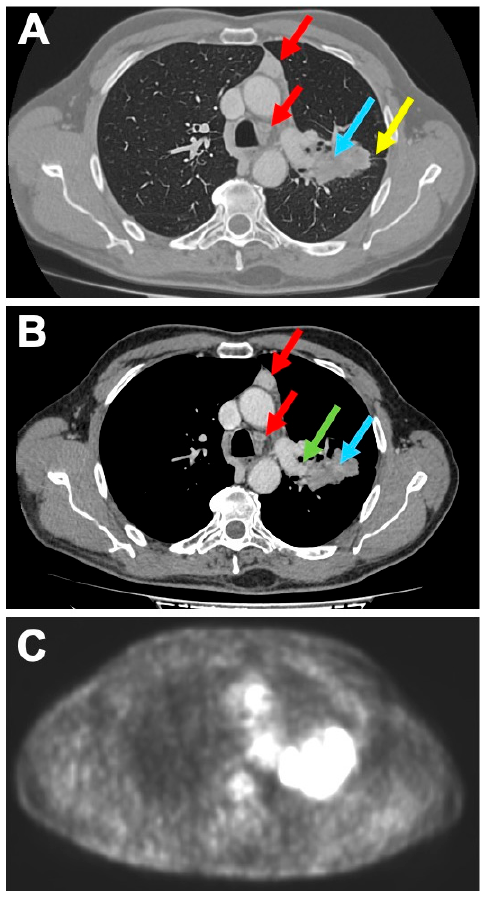
Figure 1. Contrast-enhanced computed tomography (CT) scan, lung window settings, showing two nodular mediastinal lesions (red arrows), a pulmonary mass (blue arrow), and a pulmonary fissure being infiltrated (yellow arrow) ( A ); contrast-enhanced CT scan, mediastinal window settings, showing two nodular mediastinal lesions (red arrows), a pulmonary mass (blue arrow), and the pulmonary artery being infiltrated (green arrow) ( B ); Positron emission tomography (PET) image showing pathological hyper-captation of the pulmonary mass without nodal mediastinal captation ( C ; axial level comprising the ascending and the distal tract of the aortic arch).